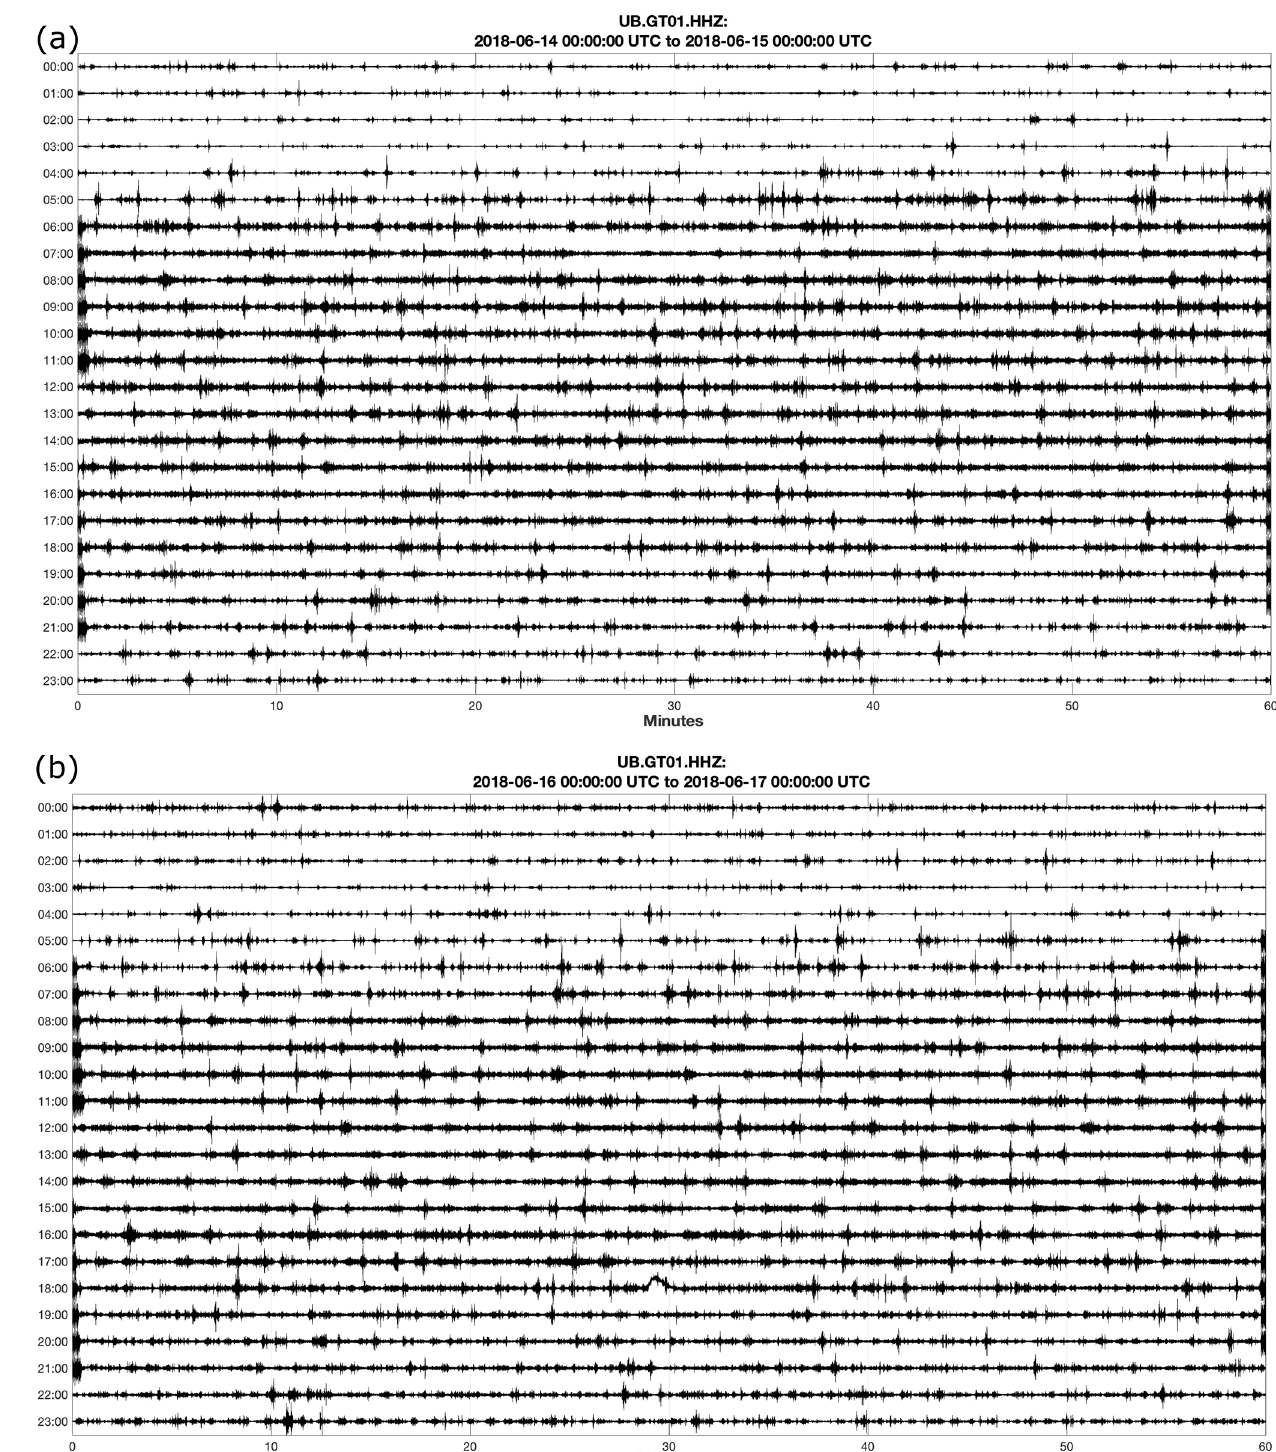
Figure 5. Helicorder recordings showing seismic signals (a) during a typical weekday near the WMB tower and (b) during a Saturday evening near the tower. During the week, while never fully quiet, activity tends to wane at night around 22:00LT in contrast to a weekend night when activity is heightened until about